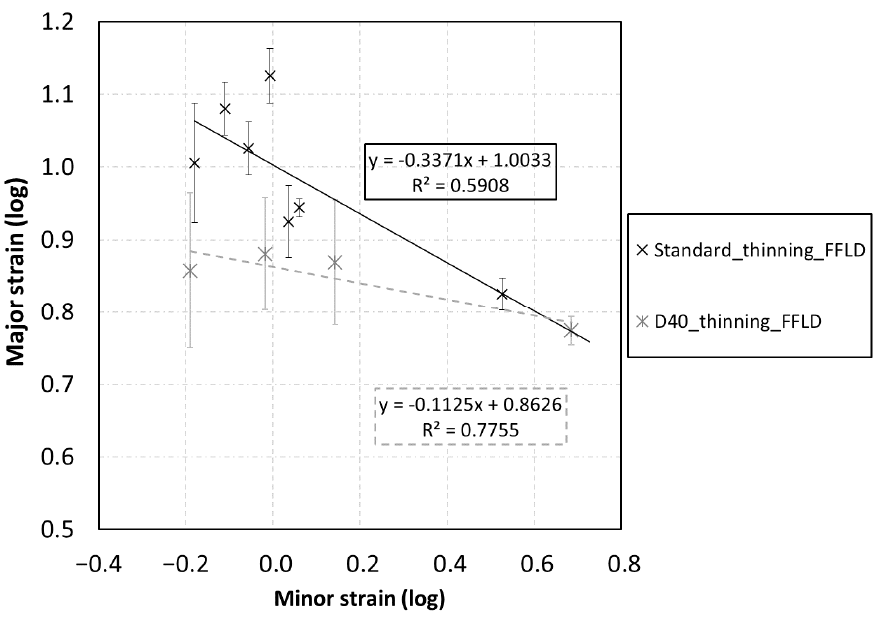
Figure 9. Comparison of the FFLDs obtained from standard and miniaturized specimens.